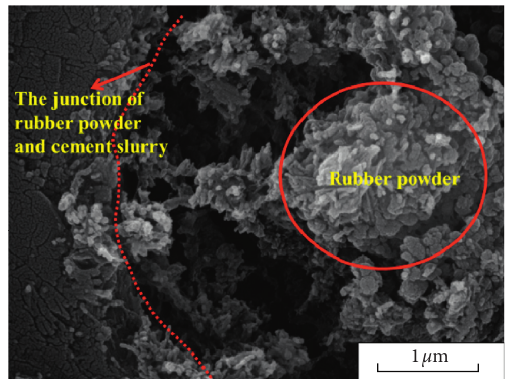
Figure 17: The internal microstructure of the rubber powder.